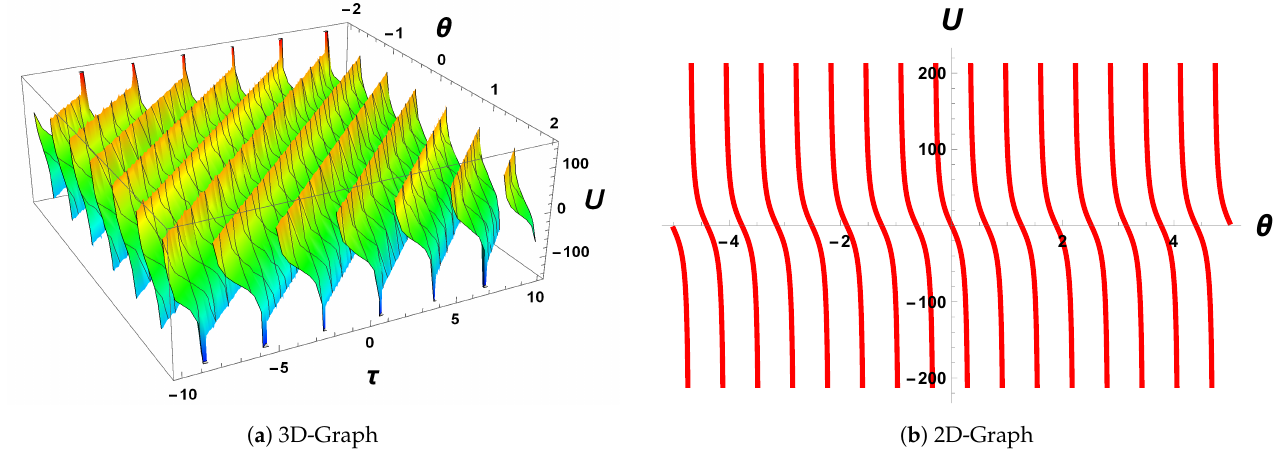
Figure 1. Diagrams a − 3 D and b − 2 D representation of U 1 ( θ , τ ) for l 1 = 1.5, l 2 = 0.75, δ = 0.50, γ 1 = 0.5, γ 2 = 0.50, and γ 3 = 0.75.